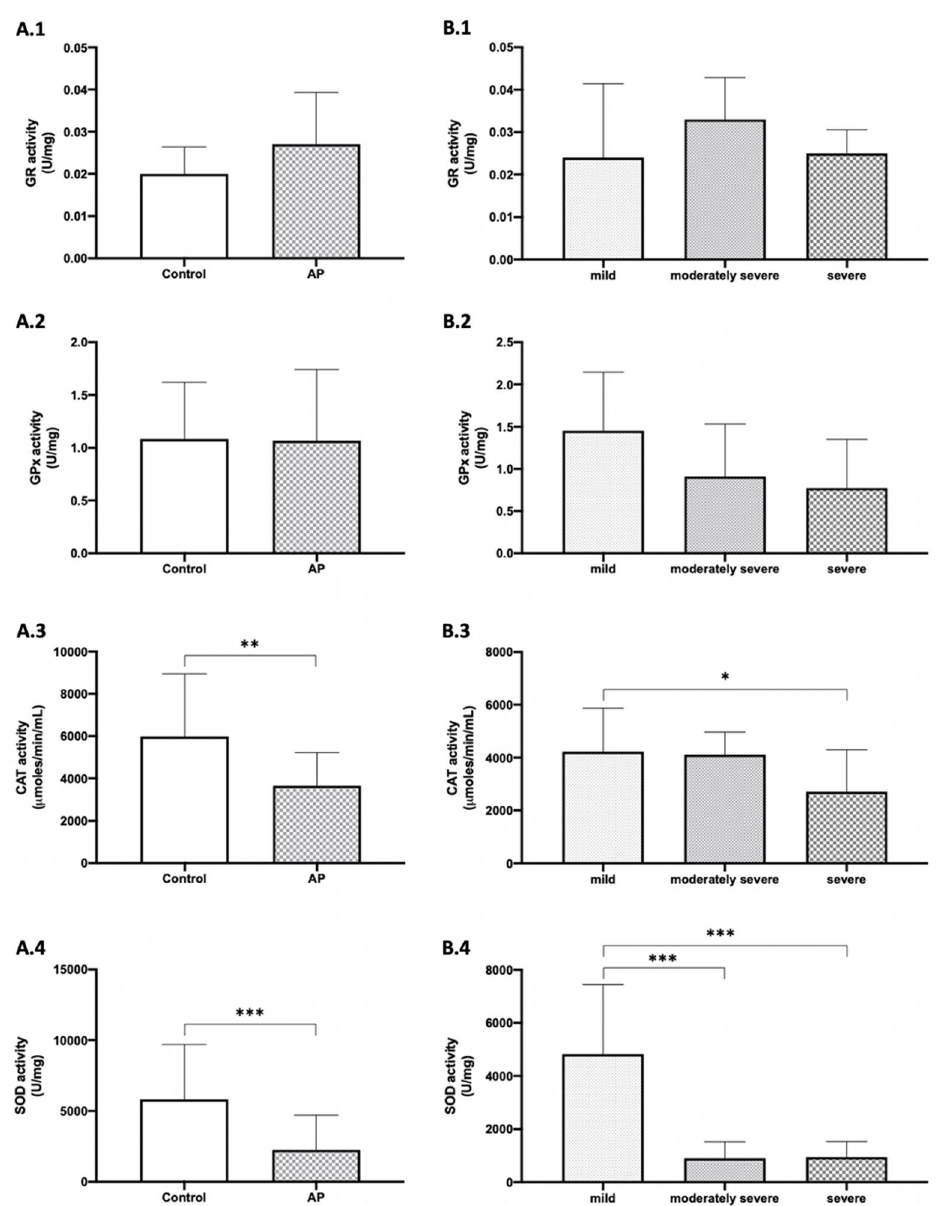
Figure 3. The activity of antioxidant enzymes in plasma of acute pancreatitis (AP) and healthy control groups. GR: glutathione reductase; GPx: glutathione peroxidase; CAT: catalase; SOD: superoxide dismutase from the healthy control group and biliary AP patients ( A ) and in the different degrees of biliary AP patients ( B ). Results are expressed as mean ± SEM. The differences versus control are marked by *, where * represents p < 0.05, ** p < 0.01 and *** p < 0.001. Mann–Whitney test: ( A.1 – A.4 ). Comparison of Fisher’s least significant difference post hoc test: ( B.1 – B.4 ).